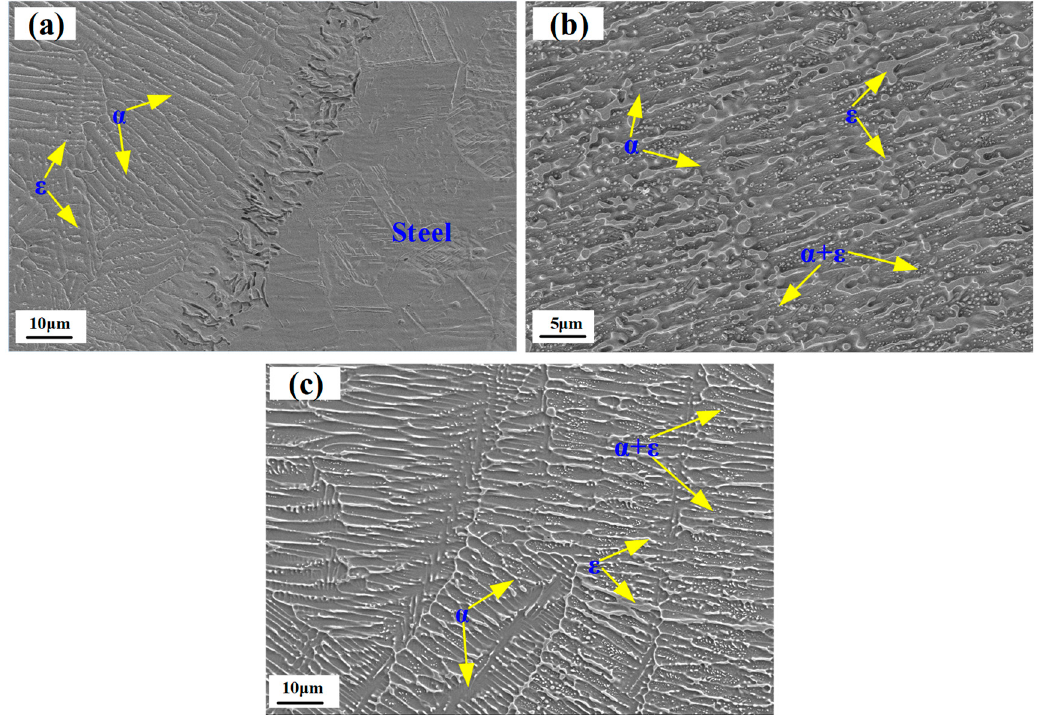
Figure 4. Microstructures of welded joints using different laser modes: ( a ) fusion zone near steel in the laser oscillating welding; ( b ) weld zone in the laser oscillating welding; and ( c ) weld zone in the laser welding.